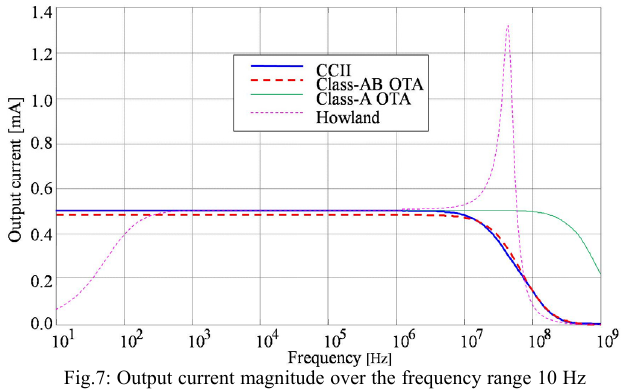
Fig.7: Output current magnitude over the frequency range 10 Hz to 1 GHz.